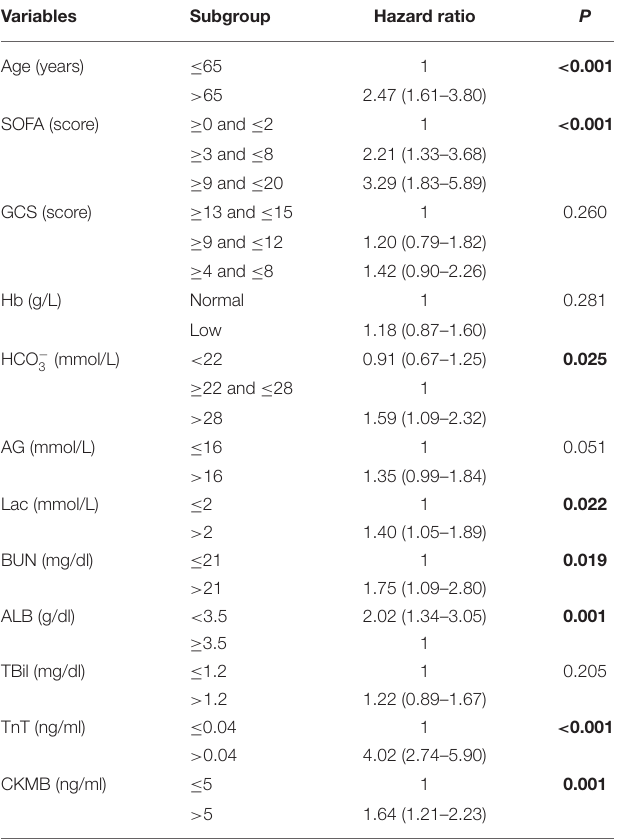
TABLE 3 | The multivariate Cox proportional hazard regression analysis of risk factors associated with 28-day mortality in patients with AHF during the first intensive care unit